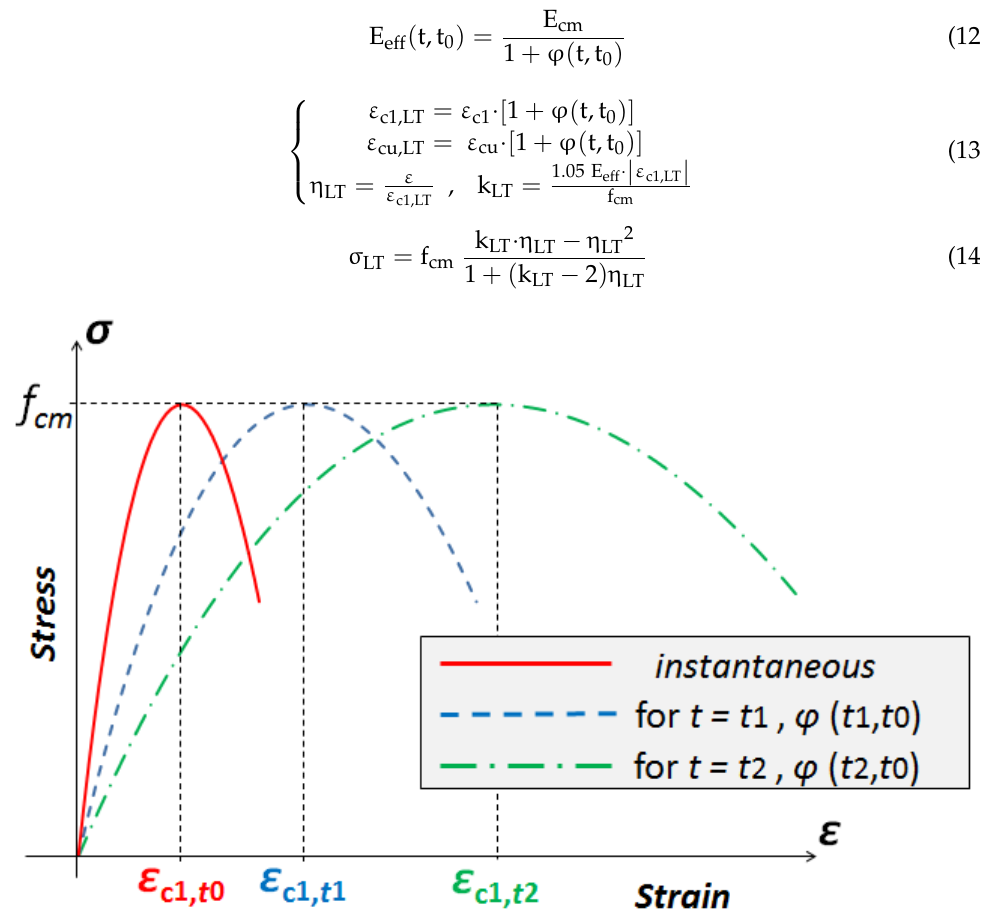
Figure 7. The adopted behavior of compressed concrete due to creep.